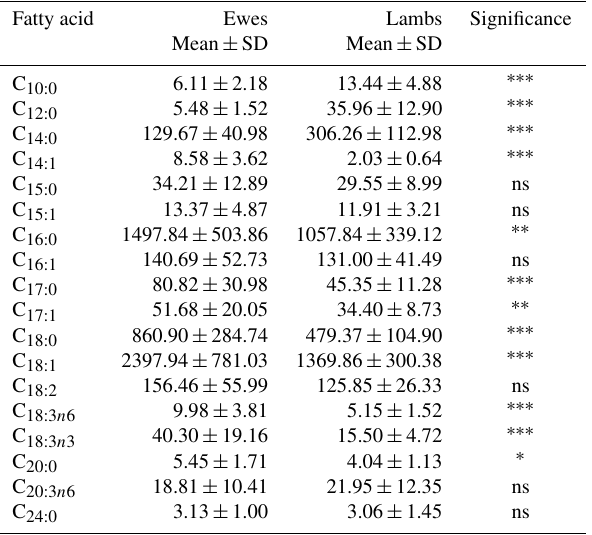
Table 4. Fatty acid selected content (mg per 100g muscle) of ewe and lamb musculus biceps femoris meat.